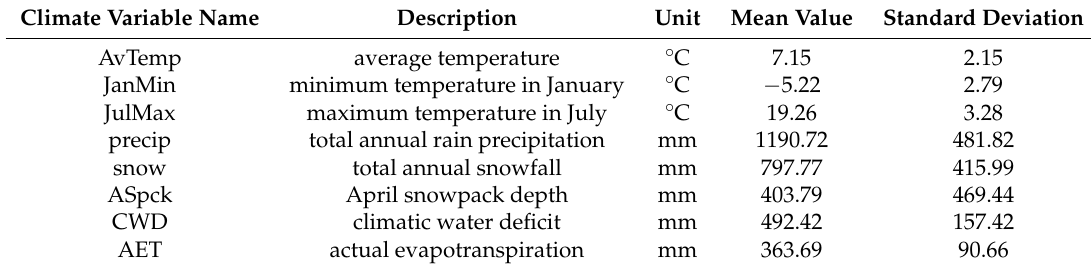
Table 3. Description of the climate variables: name used in this study, description of the variable, unit, mean and standard deviation across the plots and